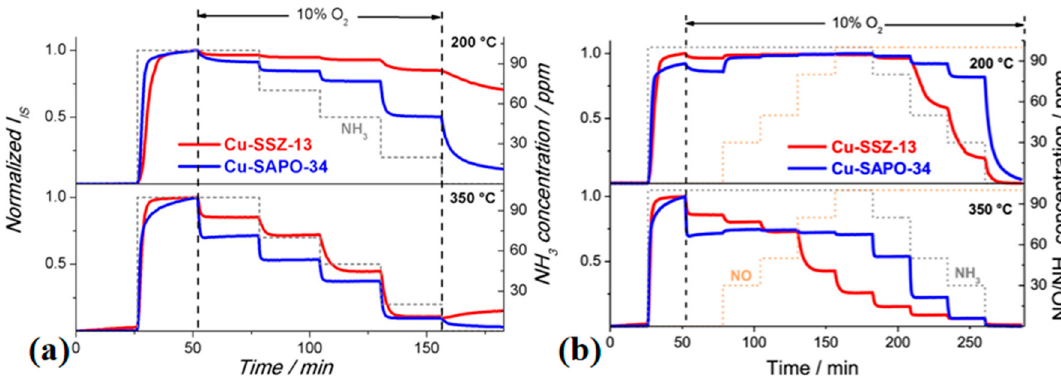
Figure 12. ( a ) NH 3 sensing performance (in terms of I IS change with the NH 3 concentration) over the Cu-SSZ-13 (red traces) and Cu-SAPO-34 (blue traces) catalysts at 200 and 350 °C and ( b ) sensing behavior (in terms of I IS change with the NO/NH 3 ratio in the fed gas mixture) under NH 3 -SCR conditions over Cu-SSZ-13 (red traces) and Cu-SAPO-34 (blue traces) commercial catalysts at 200 and 350 °C: reproduced with permission from [109], copyright American Chemical Society, 2018.